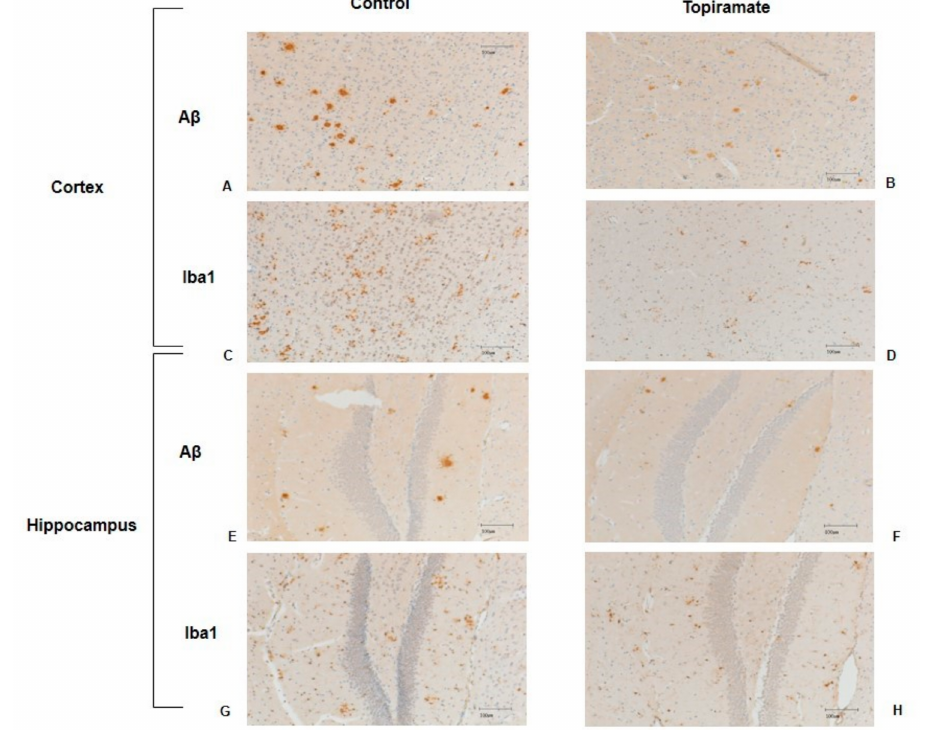
Figure 5. E ff ect of topiramate on amyloid beta (A β ) accumulation and inflammation activation. Images show the deposition of A β and microglial activation in di ff erent treatment groups. ( A , B ) APP / PS1 mice from the control group showed larger A β plaques in the cortex ( A ) in comparison to the topiramate-treated group ( B ). ( C , D ) Microglia staining for Iba-1 showed higher cell numbers and a larger IR area of microglia surrounding the plaques in the cortex of the control mice. ( E , F ) The hippocampus of non-treated mice showed larger A β plaques in comparison to treatment (topiramate). ( G , H ) Results from microglia activation by targeting Iba-1 showed that the cells were clustered around amyloid plaques and distributed throughout the hippocampus in both the control and topiramate